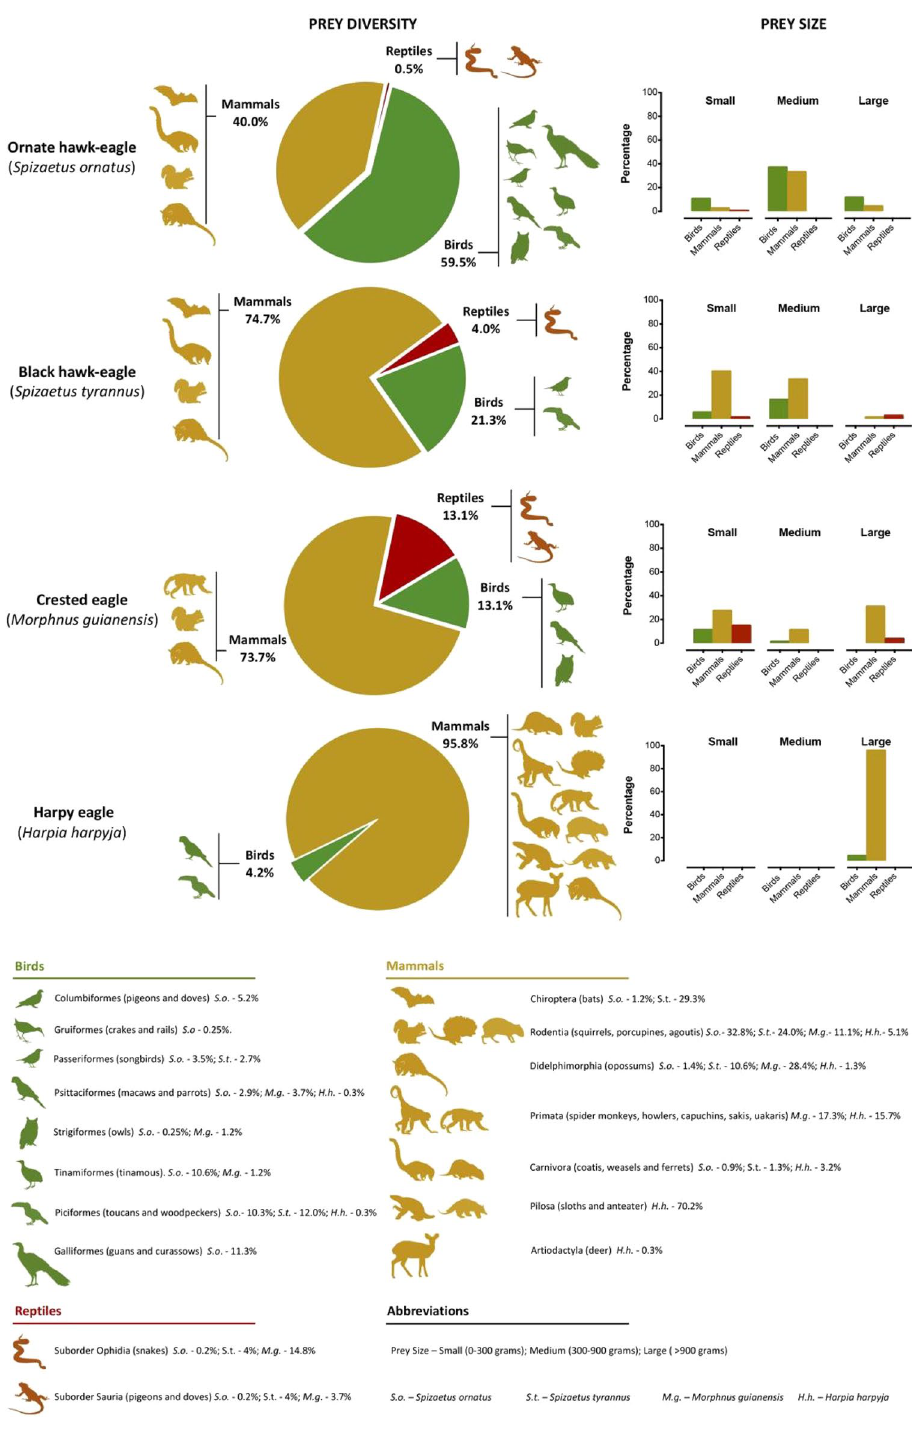
Figure 5. Prey type and size of the Ornate hawk-eagle, Black hawk-eagle, Crested eagle and Harpy eagles. The pie charts illustrate the percentages of mammals, reptiles and birds consumed by each species and the silhouettes represent the orders of the animals they prey on. The bar charts show the percentages of prey by size category (Small—0–300 g; Medium—300–900 g; and Large—> 900 g). In the lower panel, the percentages next to animal silhouettes detail how much a particular order accounts for the total prey consumed by each raptor. S.o.—Ornate hawk-eagle ( Spizaetus ornatus ); S.t.—Black hawk-eagle ( Spizaetus tyrannus ); M.g.—Crested eagle ( Morphnus guianensis ); and H.h.—Harpy eagle ( Harpia harpyja